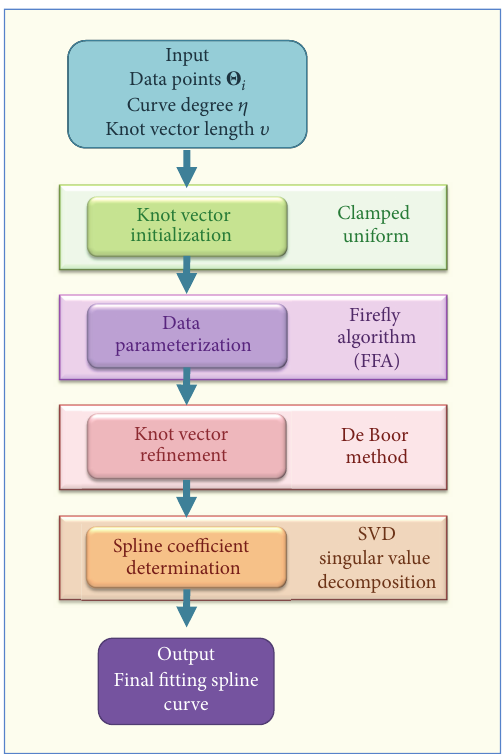
Figure 1: Graphical flowchart of the proposed